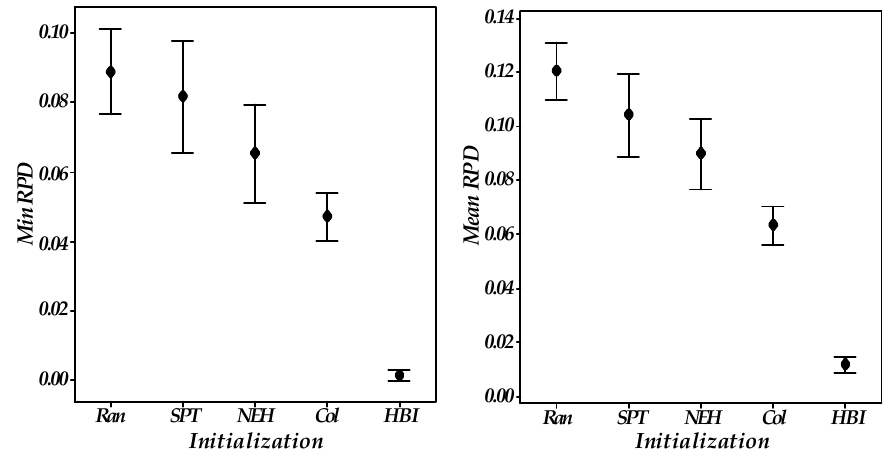
Figure 6. Comparisons of initialization rules.